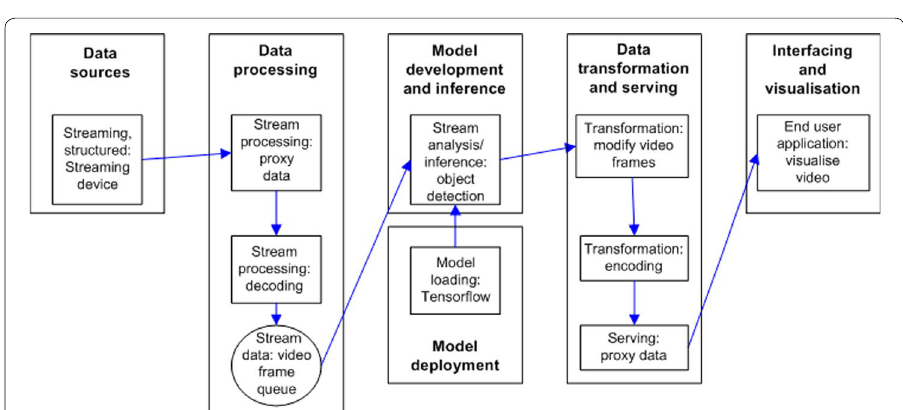
Fig. 11 The mapping of augmented reality acceleration at the edge [32] to the big data